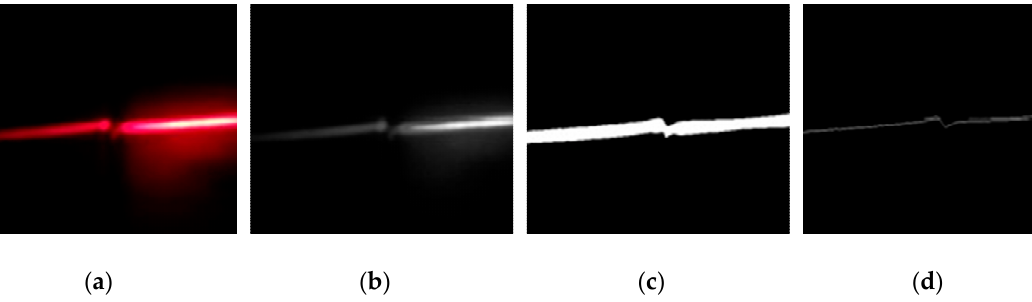
Figure 4. Images pre-processing: ( a ) RGB color space; ( b ) grayscale; ( c ) binarized image; ( d ) one-pixel width laser profile.